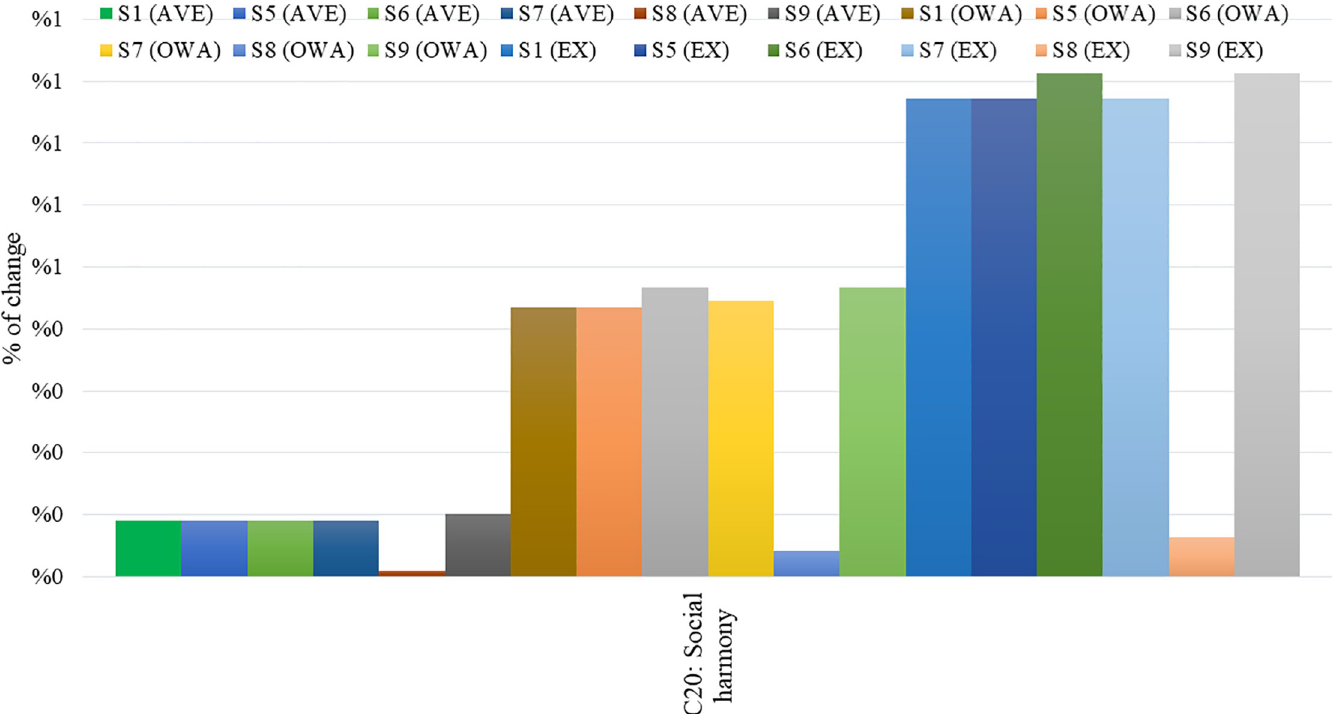
Fig 12. Outcome concept C20 percentage of change, considering confidences and